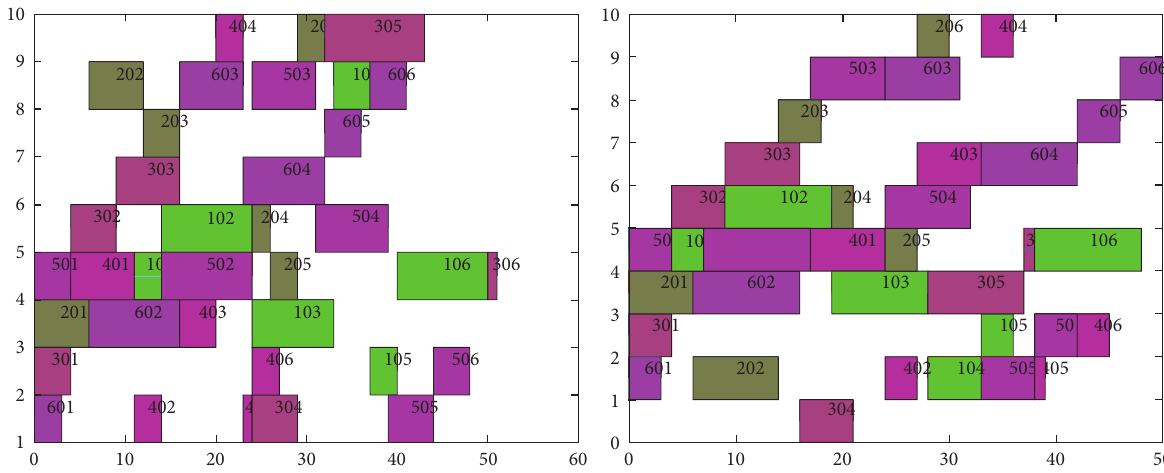
Figure 5: Comprehensive evaluation of different cross-border logistics